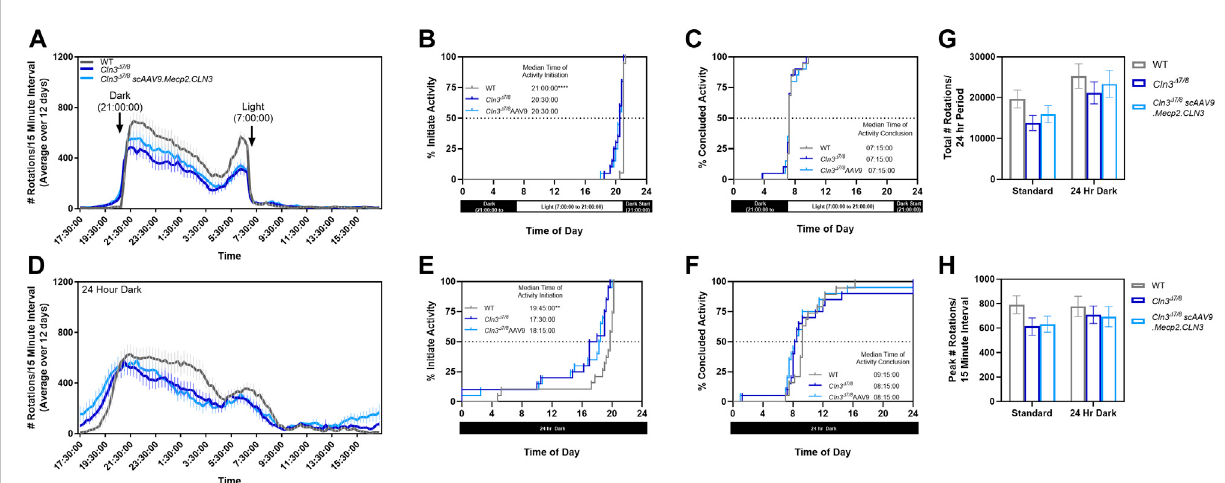
FIGURE 8 Cln3 Δ ex7/8 mice show altered circadian activity patterns. When measured in a home cage running wheel apparatus during a regular light/dark cycle (A) ,10-monthold Cln3 Δ ex7/8 miceofbothtreatmentgroupsareactivesigni fi cantlyearlierthantheirwildtypecounterparts (B,C) .Whenmeasuredduringa 24 hour dark cycle (D) , 10-month old Cln3 Δ ex7/8 mice of both treatment groups are also active signi fi cantly earlier than their wild type counterparts (E,F) . Thetotalnumberofrotations (G) andpeaknumberofrotations (H) werenotalteredbetweengroups.For (B,C,E,F) :log-rankMantel-Cox,Bonferroni post-hoc; For (G,H) : One-way ANOVA within each test cycle, Tukey post-hoc. Mean ± SEM. ** p < 0.01, **** p <